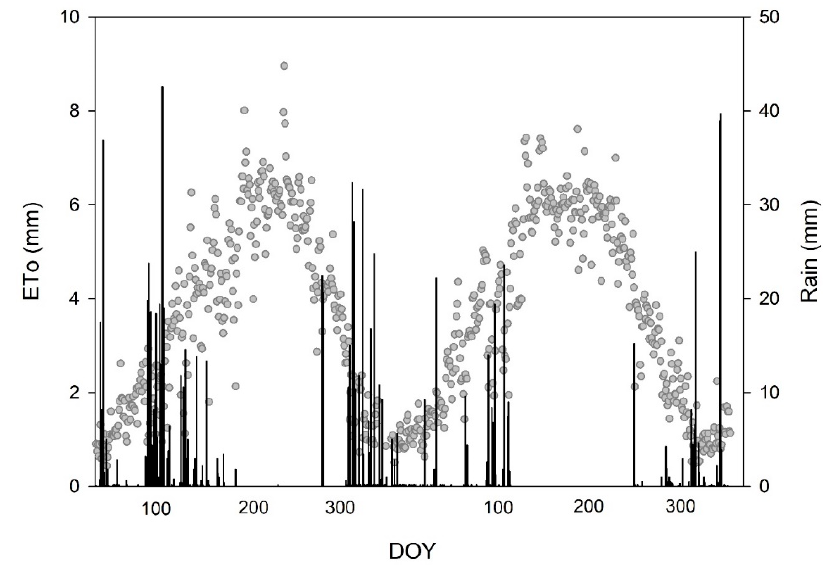
Figure 2. Daily crop reference evapotranspiration (ET 0 , dots) and daily rainfall (vertical bars) for the 2018 and 2019 seasons. Data obtained from Villanueva de Rio y Minas (Seville) meteorological